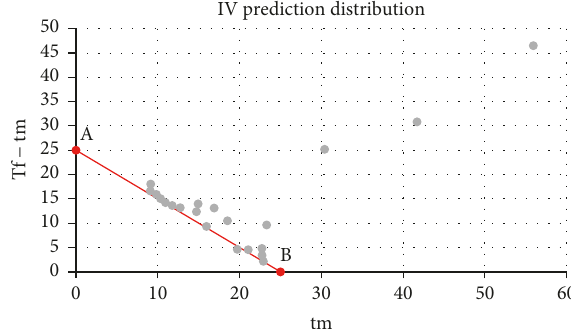
Figure 6: Distribution of failure predictions using IV method. Line AB represents failure